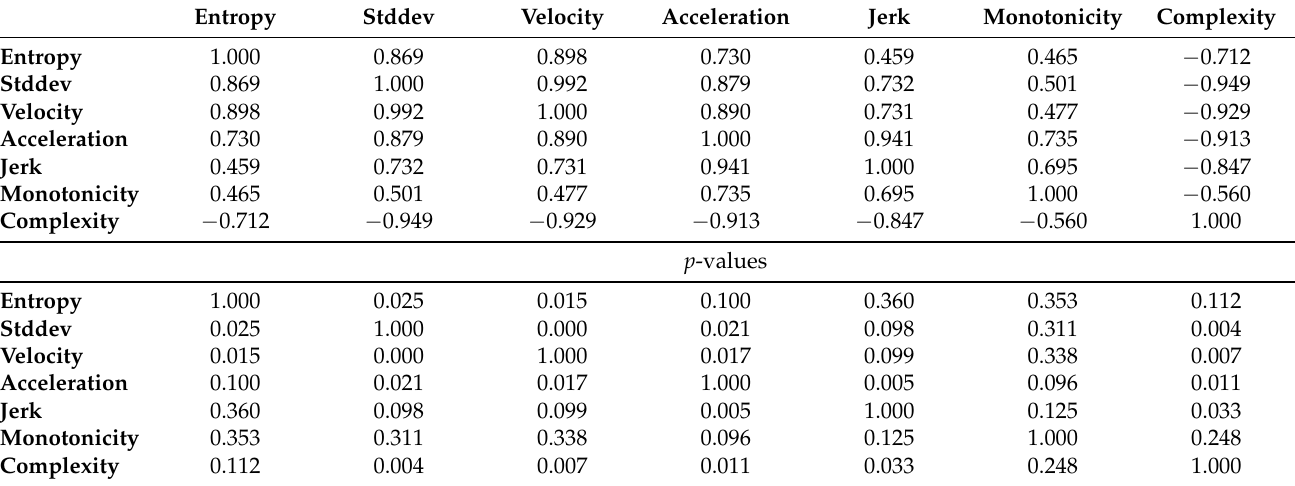
Table 6. Correlation between sequence